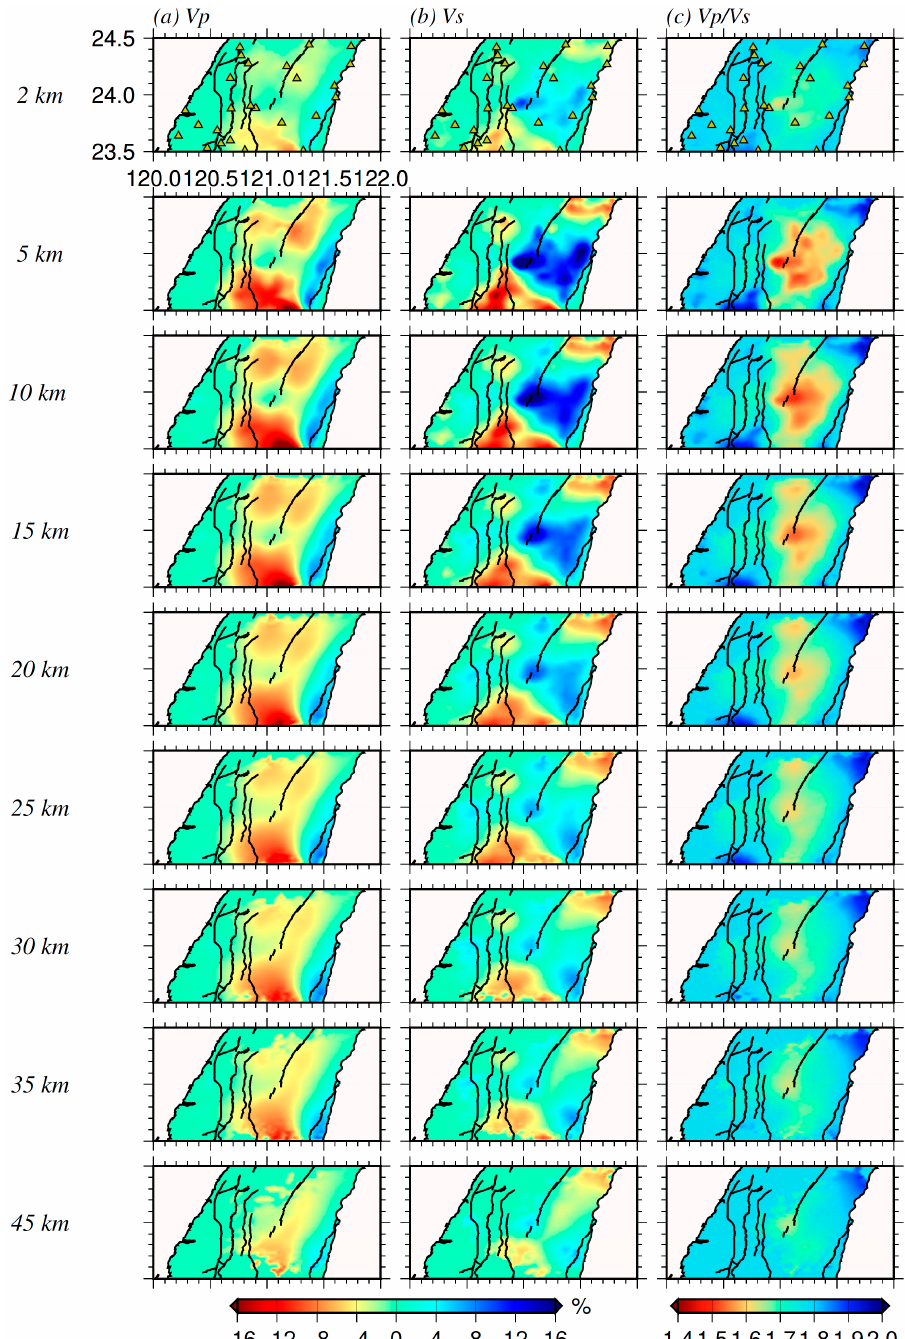
Figure A2. This study is divided into three periods to explore the Vp, Vs, and Vp/Vs in the study area. Yellow triangle represents the station. The results of Figure A2 represent the second period.